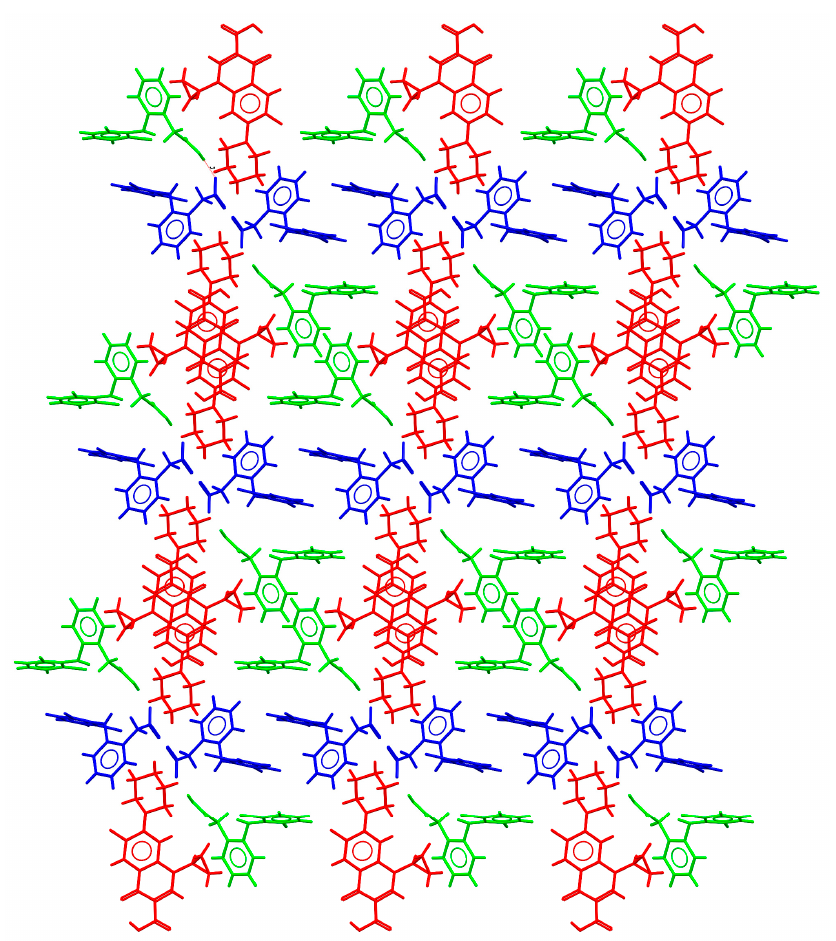
Figure 7. Detailed view of the packing arrangement of CIP cations (red) and DIC anions (blue), forming a grid in the crystal structure of CIP–DIC (neutral DIC molecules in green). The asymmetric unit of CIP–KET contained one CIP cation and a ketoprofen anion. Although tetrameric units were observed, CIP ions were associated in pairs through π – π stacking interactions but did not form infinite columns. KET anions interrupted the formation of the stacked columns, occupying the space between CIP stacked pairs. C-H ··· O (carbonyl) interactions involving CIP–CIP and KET–KET pairs reinforced the 3D structure (Figure